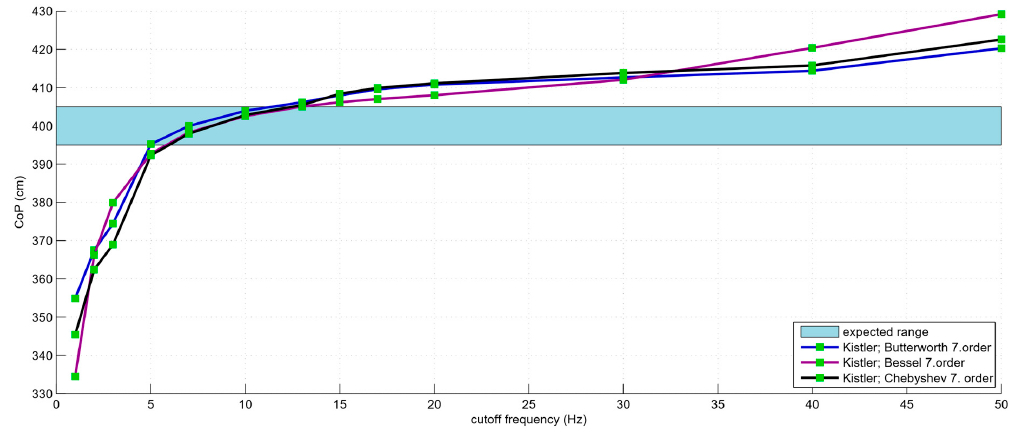
Figure 7. Representation of the characteristic curves of seventh-order Bessel, Butterworth, and Chebyshev filters.